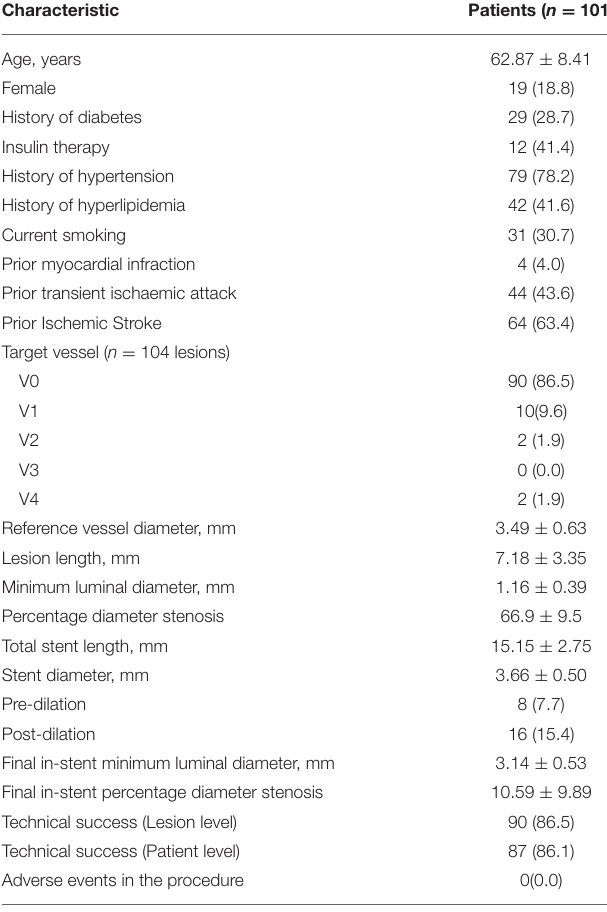
TABLE 1 | Baseline characteristics and pre/post-procedure angiographic